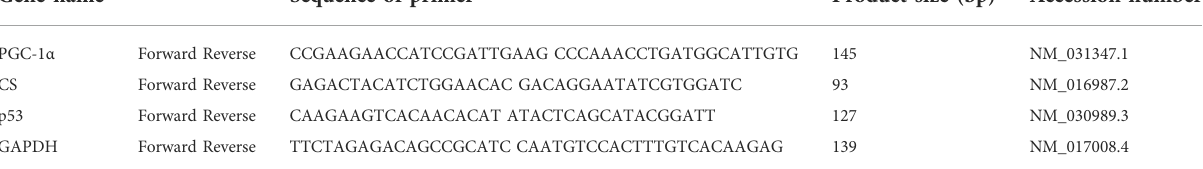
(Table 2) (Kalaki-Jouybari et al., 2020).